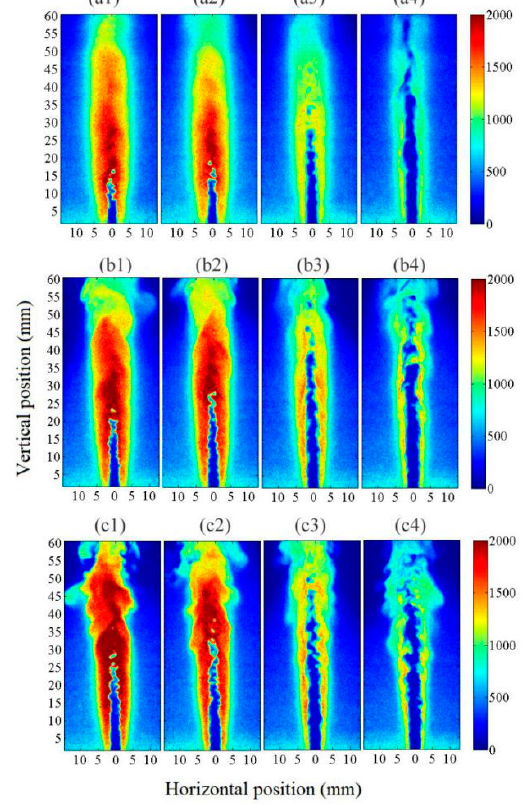
Figure 8. OH distribution instantaneous image of syngas with volumetric ratio of 75%H 2 –25%CO under different dilutions and Reynolds numbers: ( a1 – a4 ) Re = 6110; ( b1 – b4 ) Re= 10,690; ( c1 – c4 ) Re= 15,270. 1, 2, 3, and 4 indicate nitrogen dilution volumetric proportion of 0%, 10%, 30%, and 50%, respectively.